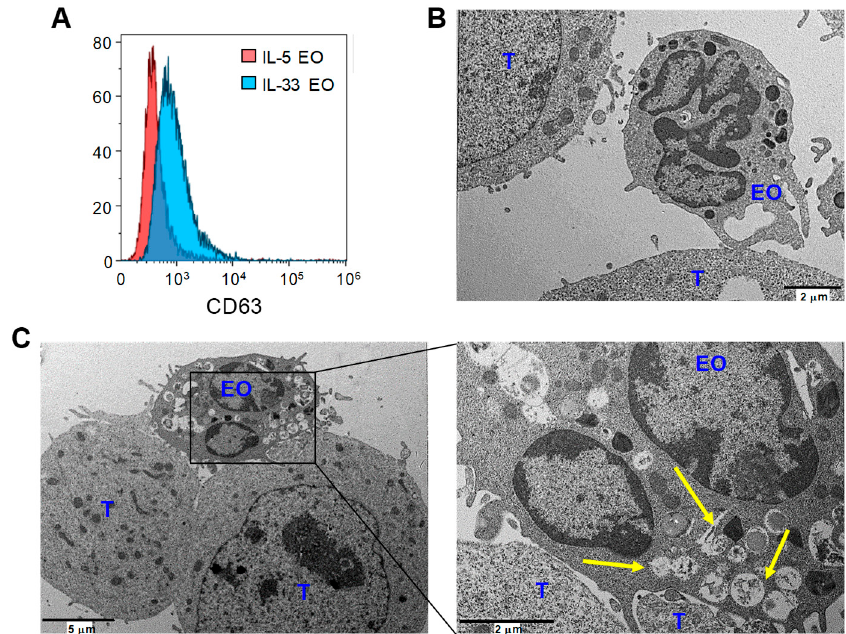
Figure 5. IL-33 increases eosinophil degranulation upon adhesion to tumor cells. ( A ) Flow cytometry analysis of CD63 surface membrane expression in IL-5 EO and IL-33 EO. Histograms from one out of three independent experiments are shown. ( B , C ) Ultrastructural analysis of IL-5 and IL-33 EO co-cultured with B16 tumor cells (T). ( B ) Representative image of IL-5 EO loosely bound to tumor cells with no evidence of granule content loss (electron-dense granules). ( C ) Representative IL-33 EO spreading elongations to take contact with two tumor cells. Enlargement shows emptying eosinophil granules with reduced electron density (indicated by arrows) in proximity to the cell contact site.